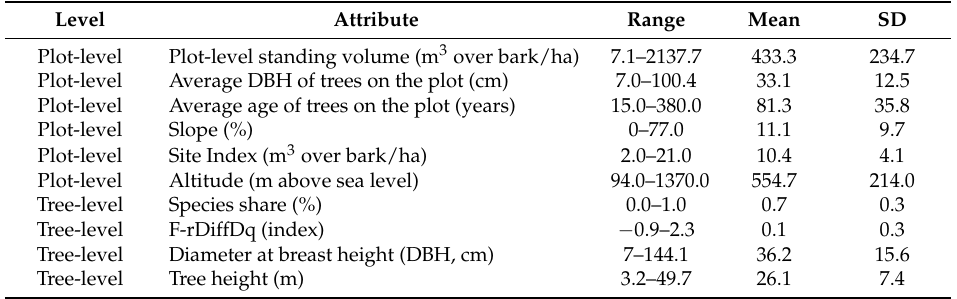
Table A1. Characteristics of continuous training set variables (5684 plots with 49,055 sample trees).